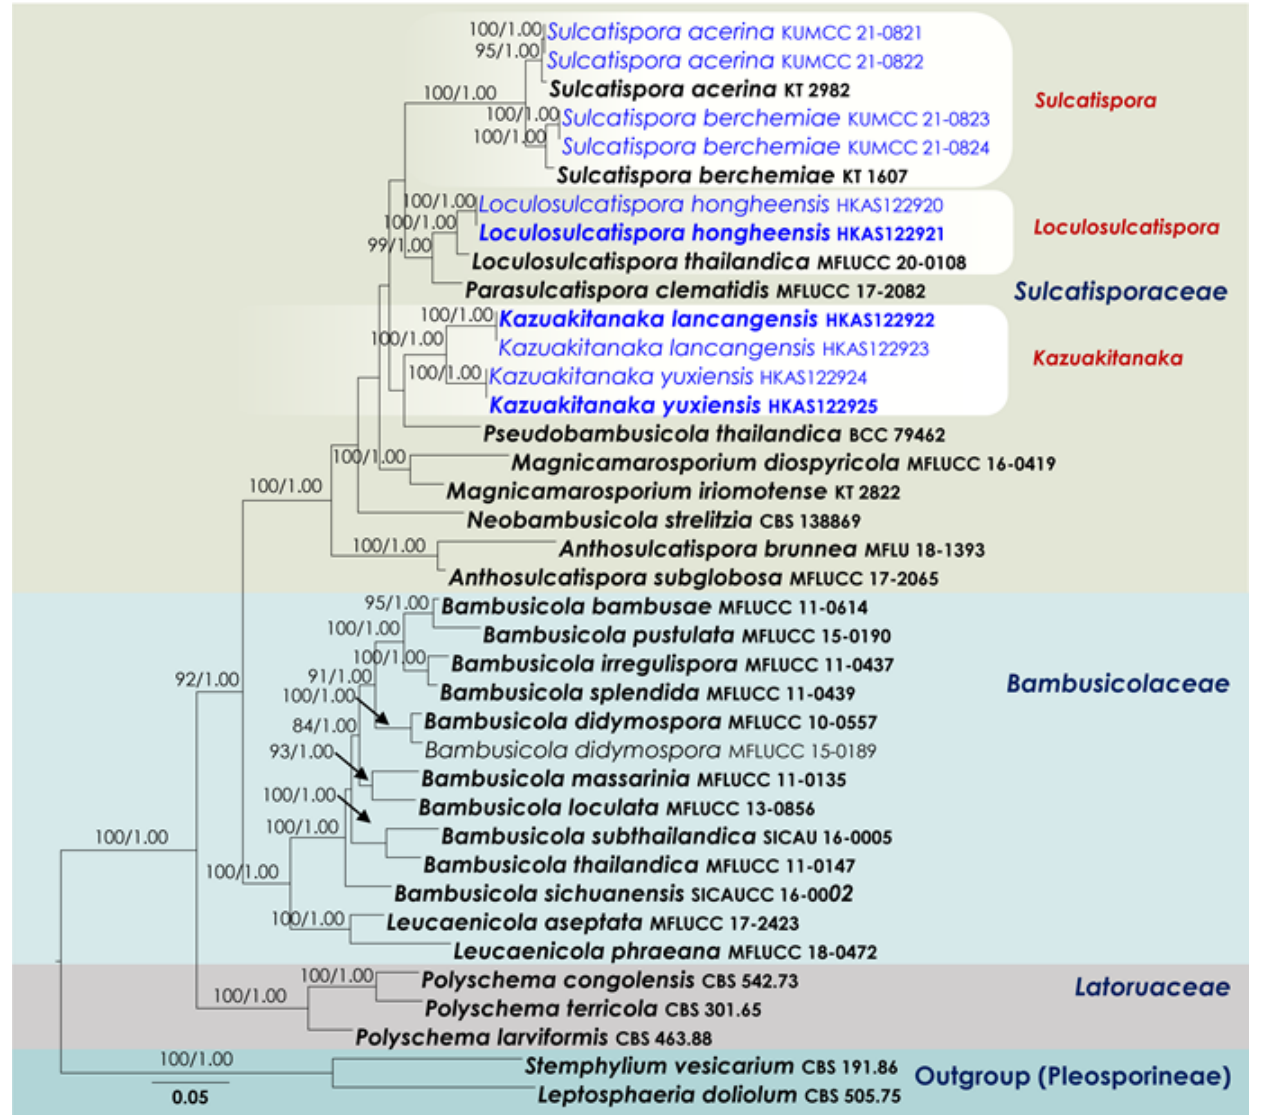
Figure 2. RAxML tree based on a combined dataset of a partial SSU, LSU, ITS, tef 1 and rpb 2 DNA sequence analysis in Sulcatisporaceae . Bootstrap support values for ML (MLB) equal to or greater than 70% and Bayesian posterior probabilities (BYPP) equal to or greater than 0.95 are shown as MLB/BYPP above the nodes. The new isolates are in blue. Species names given in bold indicate ex-type and ex-paratype strains. The scale bar represents the expected number of nucleotide substi- tutions per site.